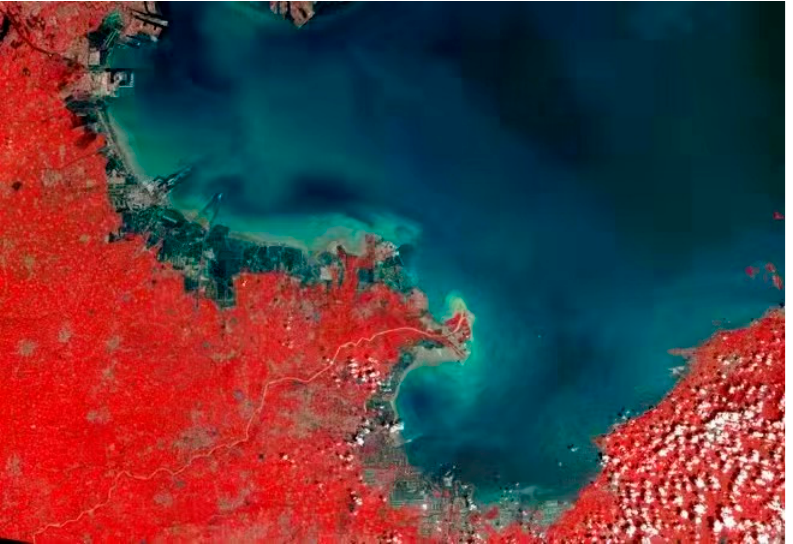
Figure 1. The Yellow River subaqueous